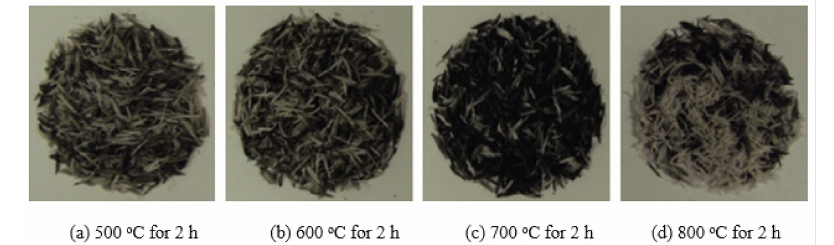
Figure 6. Changes in the RHA color at different calcination temperatures [85].